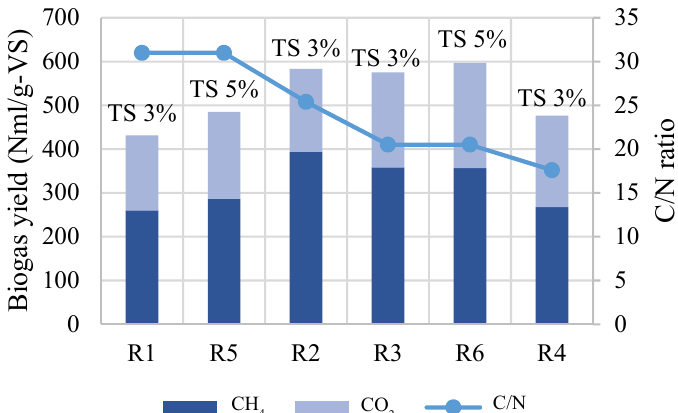
Fig. 3: Biogas yield and biogas composition from experiments